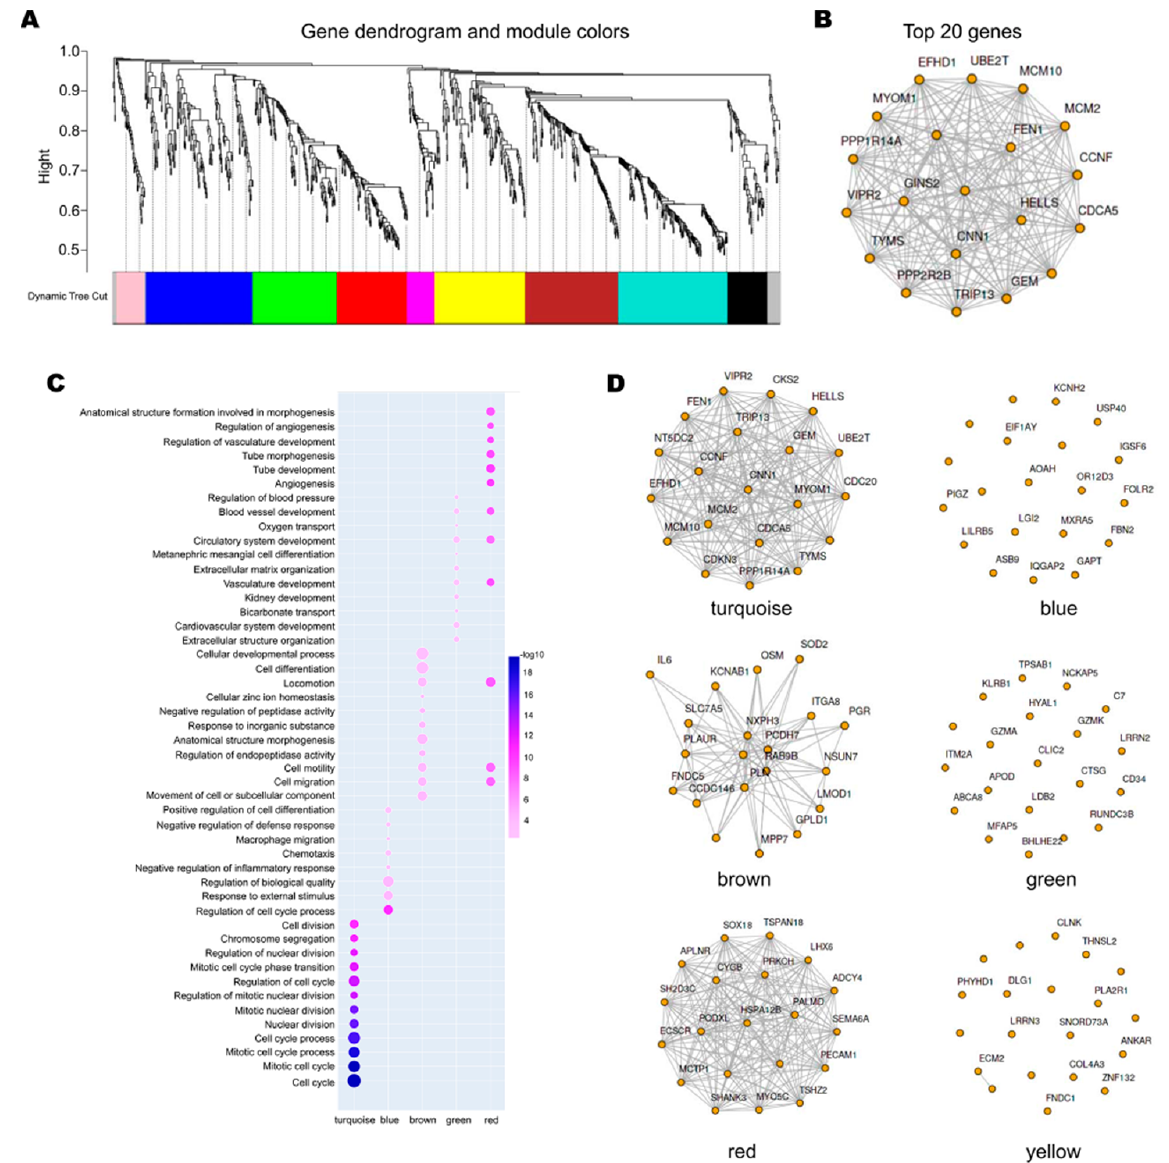
Figure 3. Weighted correlation network analysis. ( A ). Recognition module. Each module was given an individual color as an identifier, including ten different modules. ( B ). Top 20 genes of the entire network. ( C ). Biological process enrichment of genes in different modules. The significance of enrichment gradually increased from white to blue, and the dots’ sizes indicate the numbers of differentially expressed genes contained in the corresponding pathways. ( D ). Top 20 genes of different models.